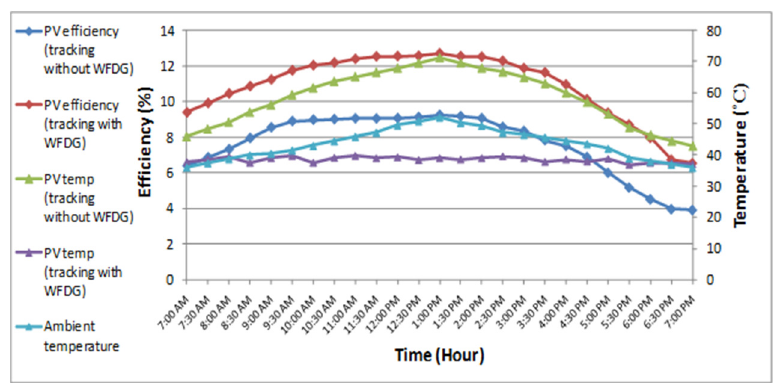
Fig. 11. Hourly performance comparison of the tracking PV panel